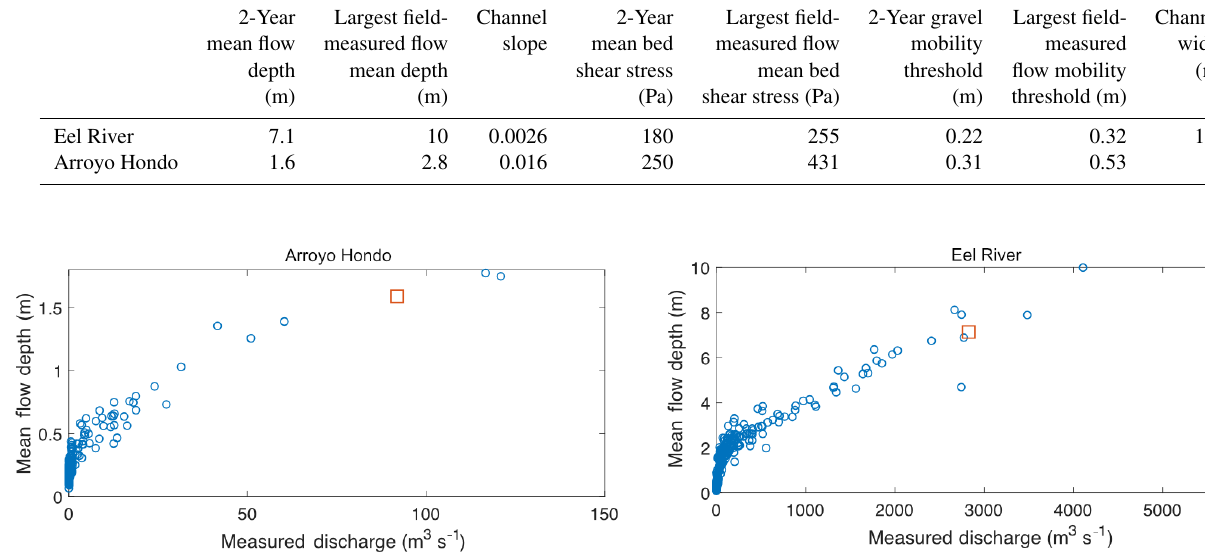
Figure 10. Mean flow depth versus measured discharge for the USGS Eel River gage at Fort Seward. Red square indicates the in- terpolated 2-year recurrence interval